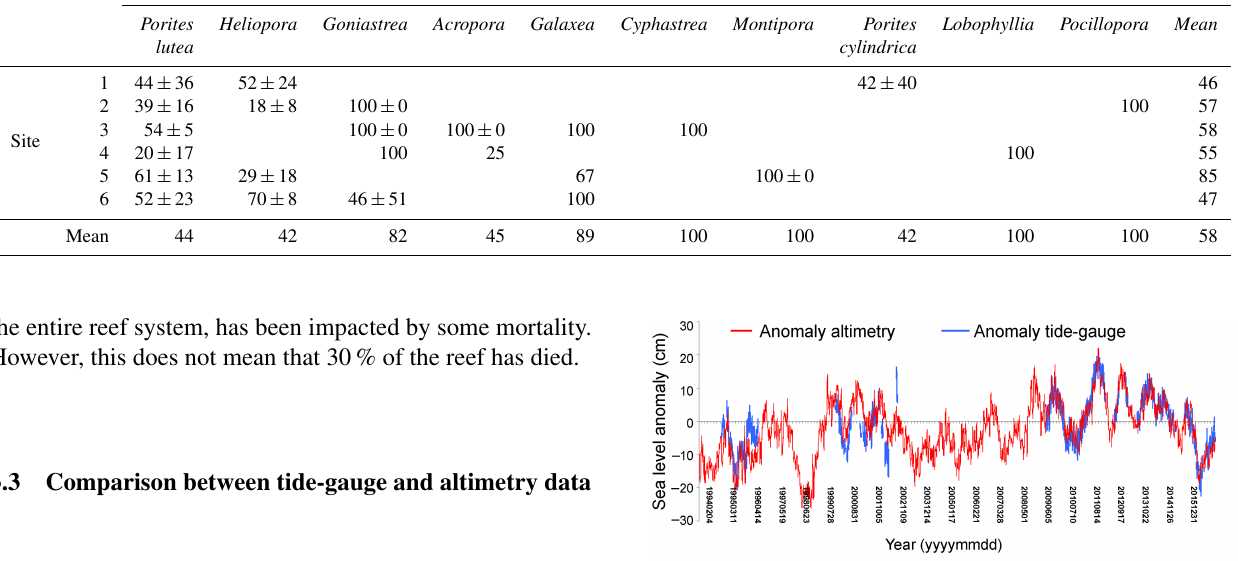
Table 1. Mortality rates (mean ± standard deviation, n = 6) of all corals for the six reef flat sites. The three dominant species were Porites lutea , Heliopora coerulea , and Goniastrea minuta . Several species and genus were found only once. Standard deviation is not shown when only one measurement per type of coral could be achieved (i.e., one colony per site). Coral